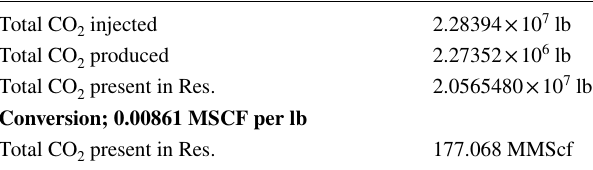
Table 6 Calculation of volume of carbon dioxide present within the reservoir after combined CO 2 EOR and sequestration Total CO 2 injected Total CO 2